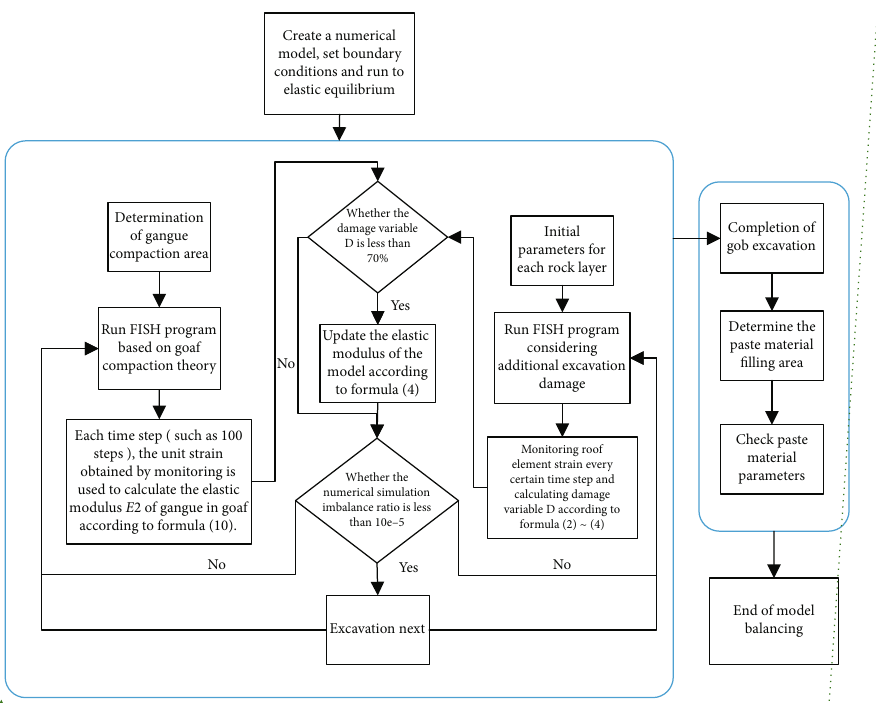
Figure 6: Flow chart of numerical simulation coupling method.